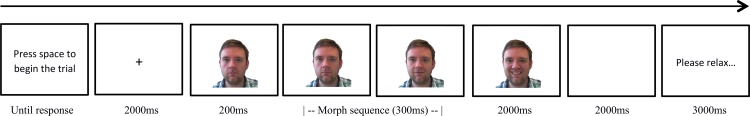
Retrieval Stage trial.A typical trial from the Retrieval Stage with details of timings.